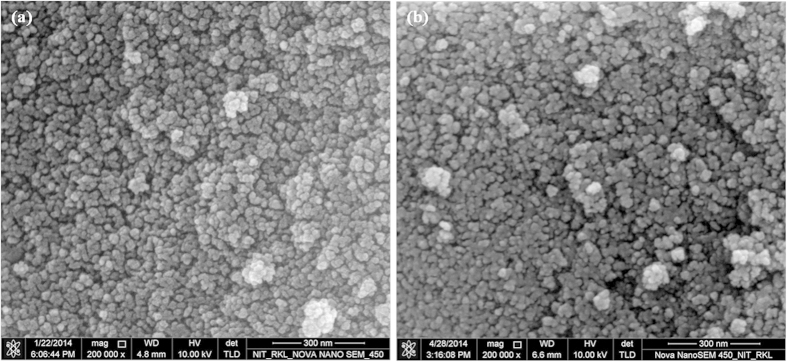
FE-SEM image of n-IONP (Fig. 2a) and p-IONP (Fig. 2b).